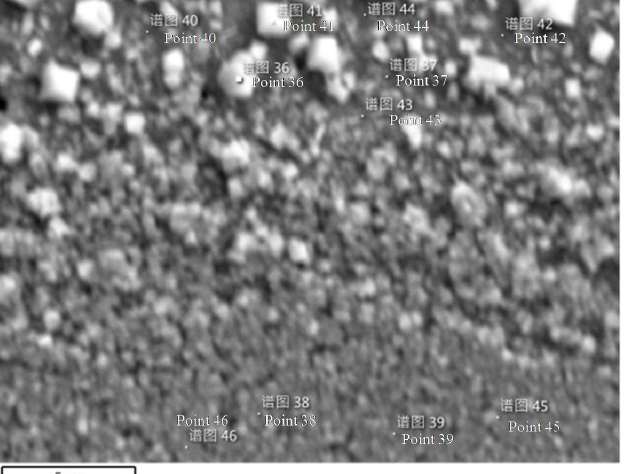
Figure 10. Surface scan of the Zr alloy after corrosion in a 360 °C high-temperature and high-pressure water environment for 14 days: ( a ) Distribution diagram of O; ( b ) Distribution diagram of Zr; ( c ) Distribution diagram of Sn.